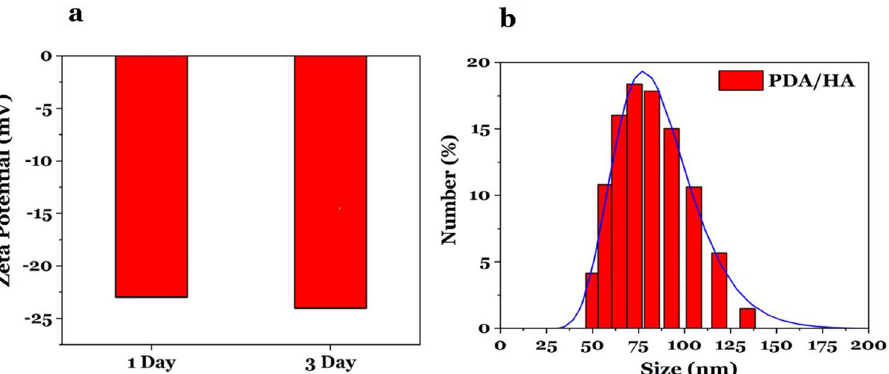
Figure 12. Stability test of PDA/HA/Gd 3+ NPs in human serum at 37 °C for 3 days. ( a ) The hydrodynamic diameter of the NPs at days 1 and 3. ( b ) The zeta potential of the NPs at days 1 and